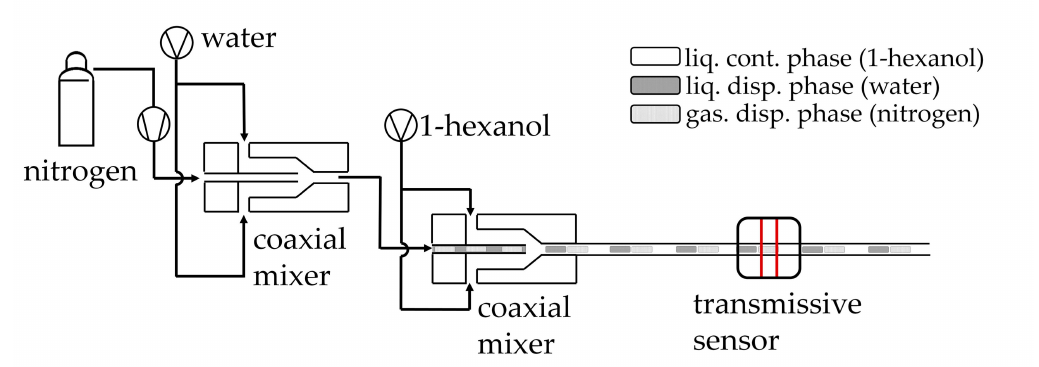
Figure 3. Schematic of the set-up used to generate the triphasic segmented slug flow. Left: Generating a biphasic slug flow of water and nitrogen in the first coaxial mixer. Middle: The continuous phase 1-hexanol encircles in the second coaxial mixer the biphasic flow generating a triphasic slug flow. Right: Detection of the slug flow with a transmissive